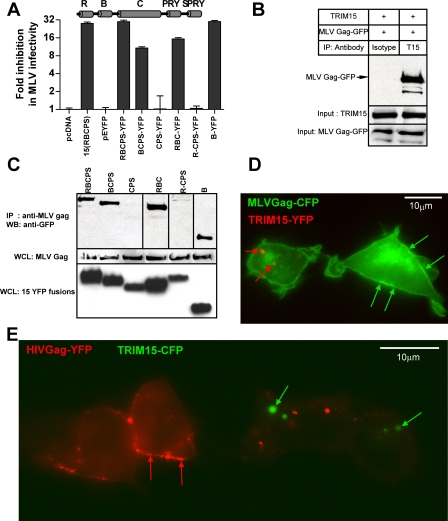
The Antiviral Activity of TRIM15 Resides in Its B-box(A) Fold inhibition in MLV released infectivity in presence of indicated TRIM15-YFP derivatives. The vectors pcDNA or pEYFP were used as controls. Top schematic displays the TRIM15 domain structure.(B) Western blot using GFP antibodies to detect MLV Gag-GFP that co-immunoprecipitated with antibodies against TRIM15.(C) Western blot using antibodies to GFP to identify TRIM15-YFP derivatives that co-immunoprecipitated with MLV Gag.(D) MLV Gag-CFP (green), full length MLV and TRIM15-YFP (red) were transfected into HEK293 cells and monitored 24 h later. Green arrows indicate the accumulation of Gag at the plasma membrane. Red arrows point to cytoplasmic TRIM15 bodies.(E) An experiment as described in (D) was performed for HIV Gag-YFP (red) and TRIM15-CFP (green).